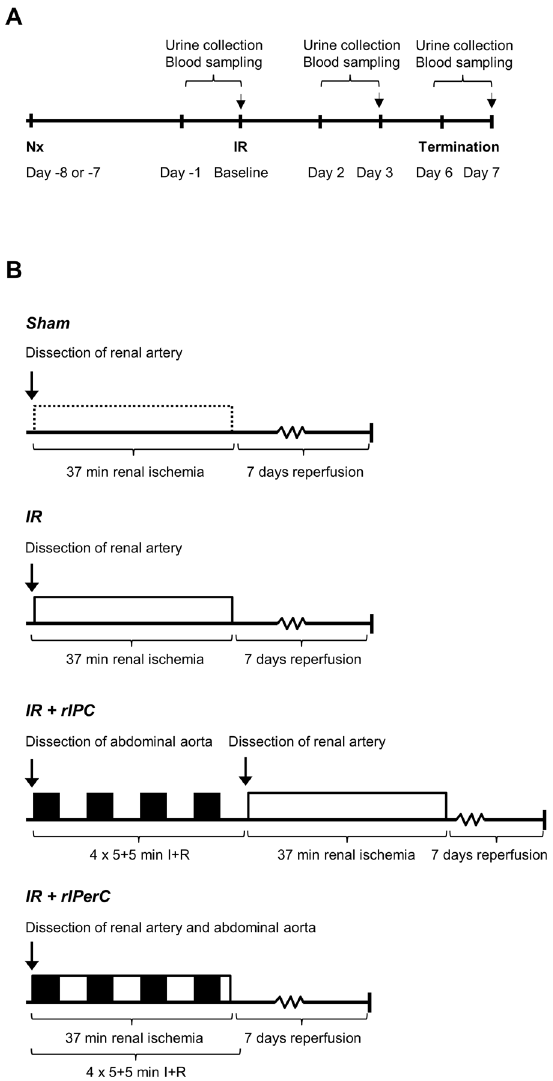
Fig 1. The study design and the four experimental groups. A) All animals underwent right nephrectomy 7 – 8 days prior to the renal ischemia-reperfusion injury or sham operation. Urinary creatinine clearance was determined prior to renal ischemia-reperfusion (IR; termed baseline) and days 3 and 7 post-operatively. B) The remote ischemic conditioning stimulus was applied as four cycles of 5 minutes of ischemia and 5 minutes of reperfusion by clamping the infrarenal aorta either before (remote ischemic preconditioning; rIPC) or during (remote ischemic perconditioning; rIPerC) 37 minutes of unilateral renal ischemia.